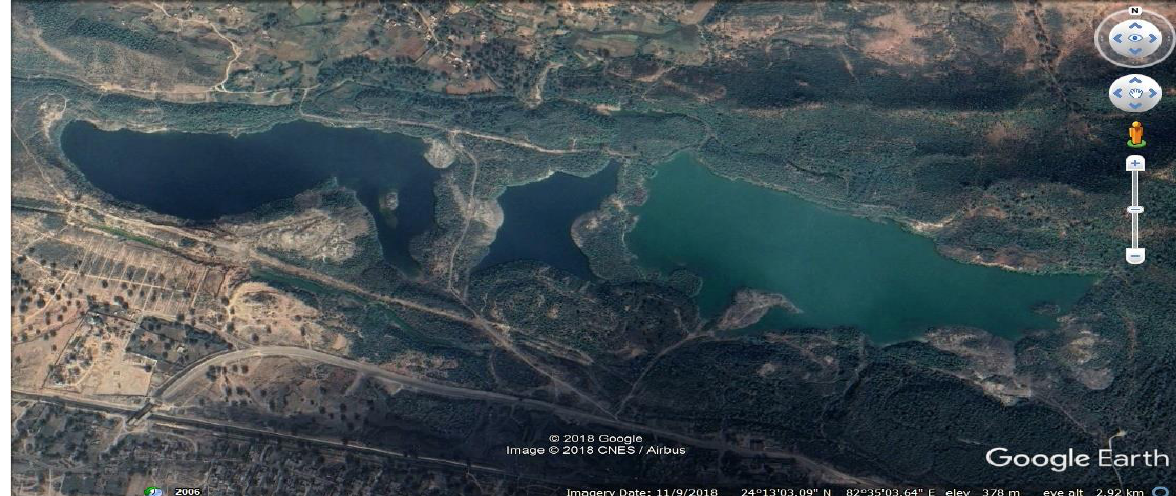
Figure 2. The Gorbi abandoned mine, showing Pits I, II and III (via Google Earth).